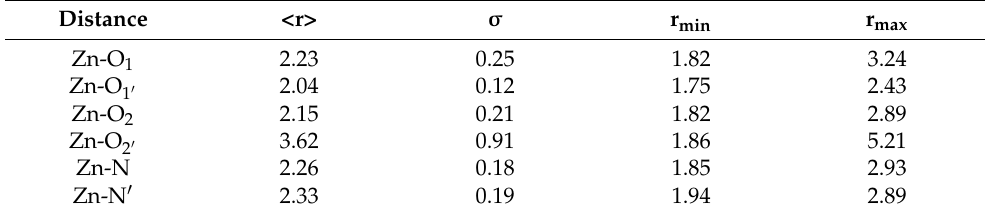
Table 1. Average metal-ligand bond distances <r> , standard deviation σ , minimum r min and maxi- lated SiO 2 surface at the PBE-D2/PW level. All distances are in Å. For atom labeling, see Figure 2. Distance <r> σ r min